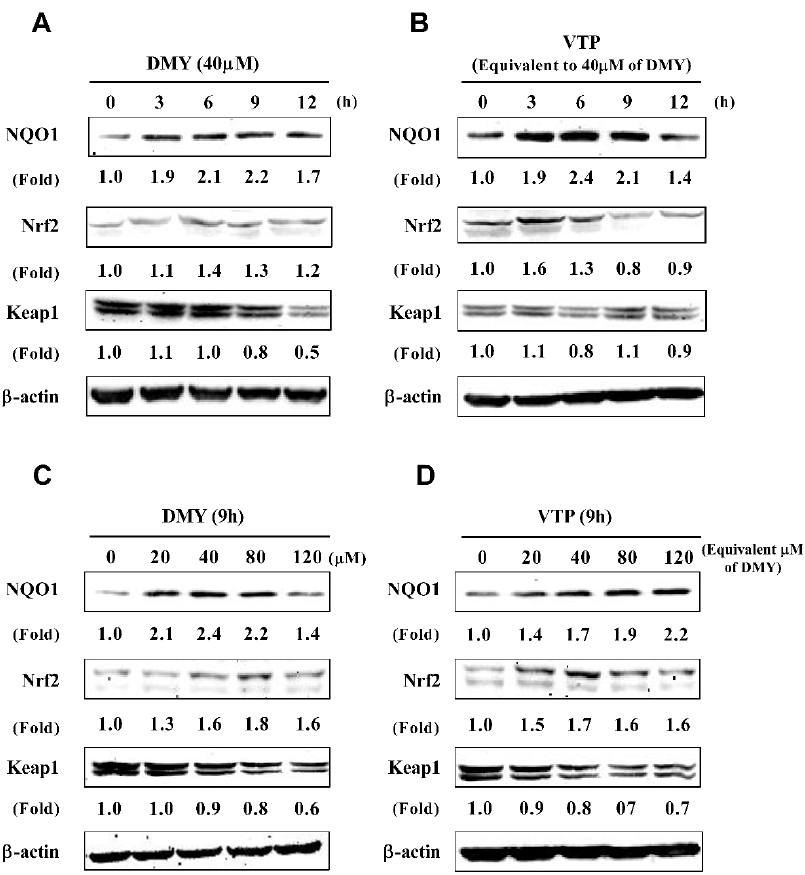
Figure 5. Effects of DMY and VTP on the level of nicotinamide adenine dinucleotide phosphate (NADPH):quinone oxidoreductase (NQO1), nuclear factor erythroid 2-related factor 2 (Nrf2) and Kelch-like ECH-associated protein 1 (Keap1) proteins. A time-effect of DMY ( A ) and VTP ( B ) on the level of NQO1, Nrf2 ,and Keap1 proteins. HepG2 cells were treated with DMY (40 μM) or VTP (equivalent to 40 μM DMY) for 0–12 h. A dose-effect of DMY ( C ) and VTP ( D ) on the level of NQO1, Nrf2, and Keap1 proteins. HepG2 cells were treated with DMY (20–120 μM) and VTP (equivalent to 20–120 μM DMY) for 9 h. The fold was normalized with the control protein, -actin, and obtained from triplicate blot data.